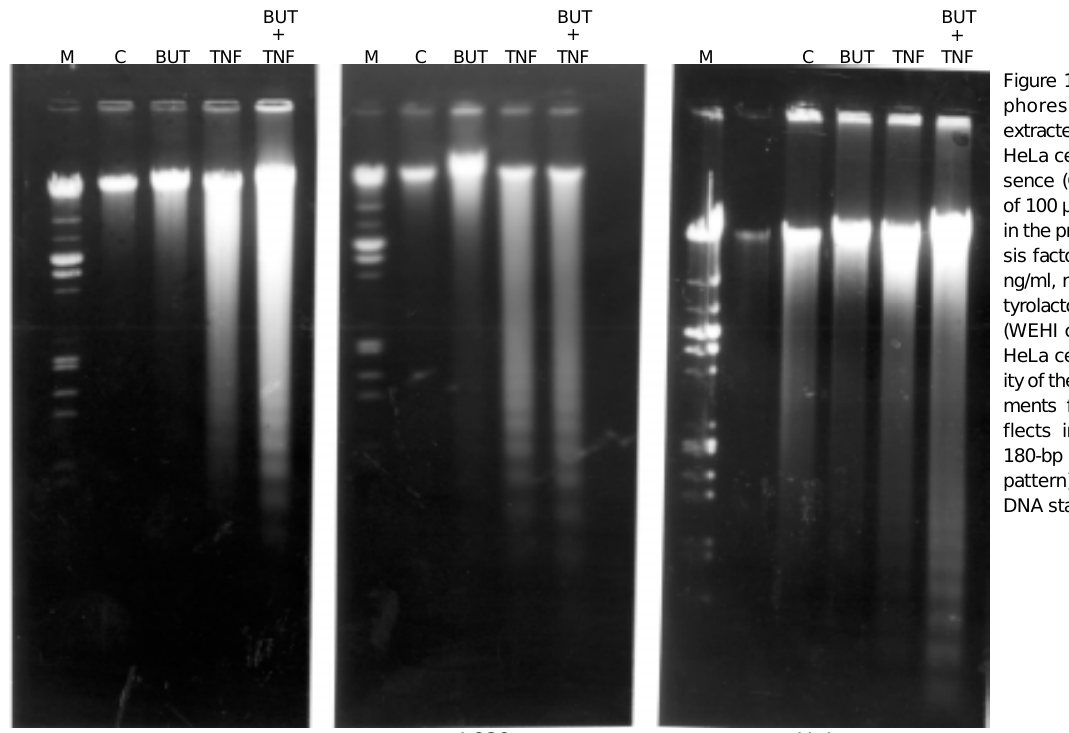
Figure 1 - Agarose gel electro- phoresis of genomic DNA extracted from WEHI, L929 and HeLa cells incubated in the ab- sence (C) and in the presence of 100 µM butyrolactone (BUT), in the presence of tumor necro- sis factor (TNF) at 1, 5 and 100 ng/ml, respectively, or both bu- tyrolactone and TNF for 15 h (WEHI cells) or 24 h (L929 and HeLa cells). The relative mobil- ity of the oligonucleosomal frag- ments from DNA samples re- flects interger multiples of a 180-bp unit (apoptosis ladder pattern) with respect to the DNA standard